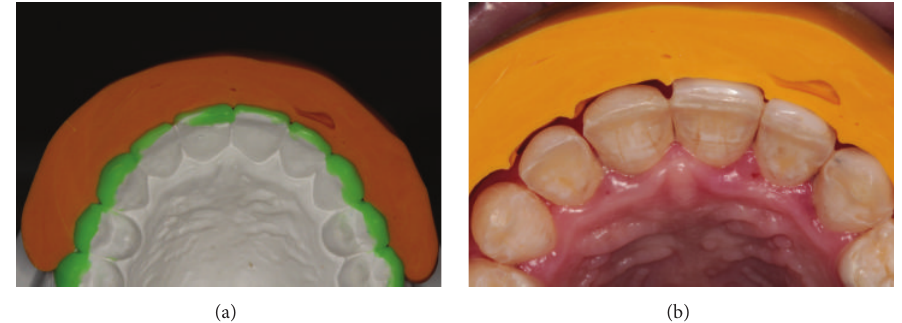
Figure 5: Wear guide made with addition of silicone over wax (a) and on teeth (b) during wear of composite resins to assess thickness of the restoration